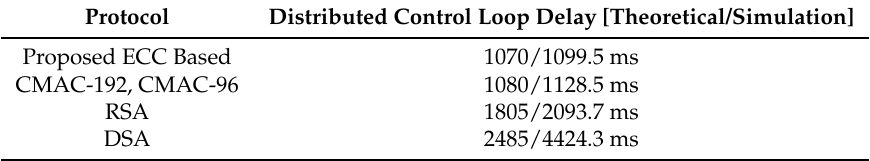
Table 4. Maximum Distributed Control Loop